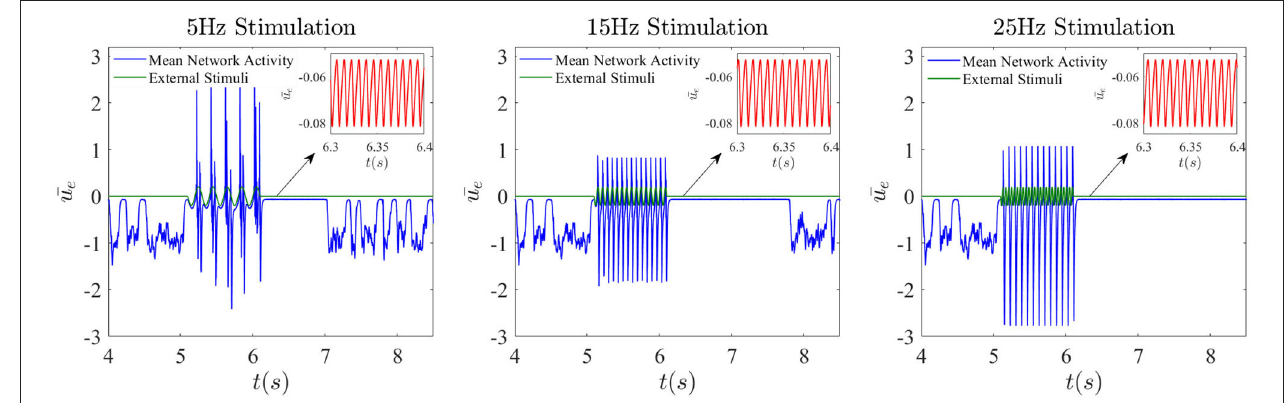
5.1 s until t 6.1 s. = =